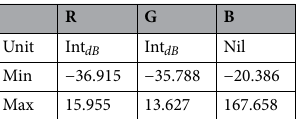
Table 2. Statistical summary of σ